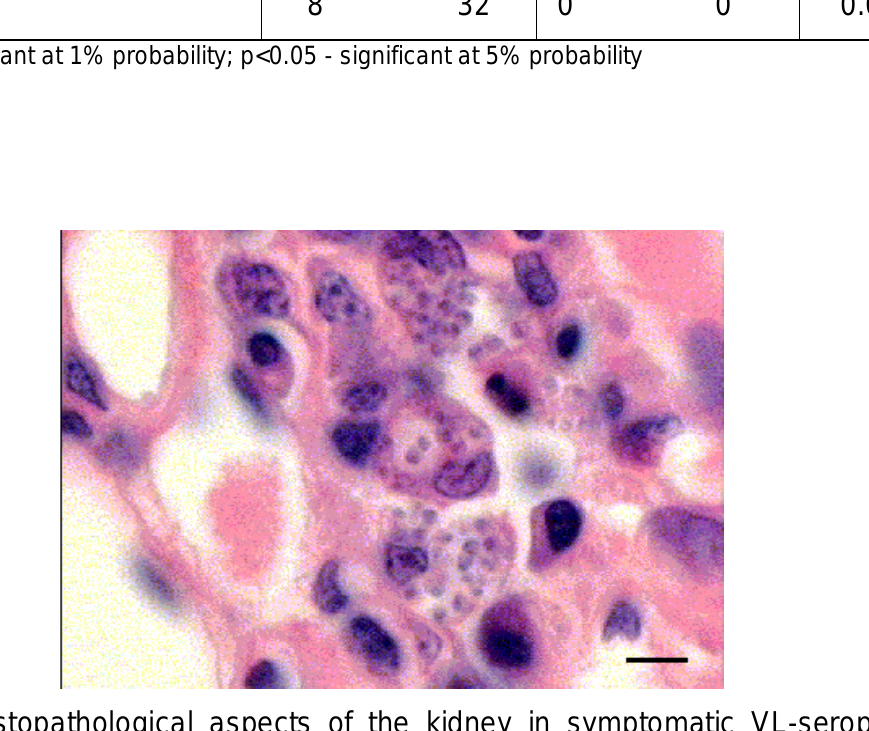
Figure 1. Histopathological aspects of the kidney in symptomatic VL-seropositive